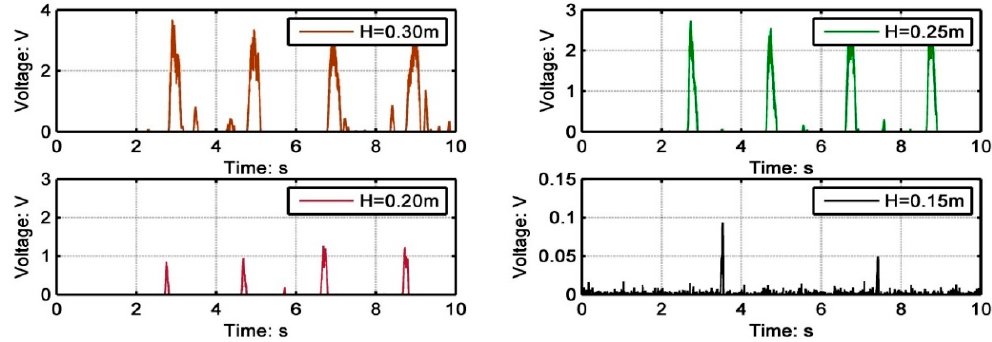
Figure 14. Voltage curves when the wave period is 2 s.